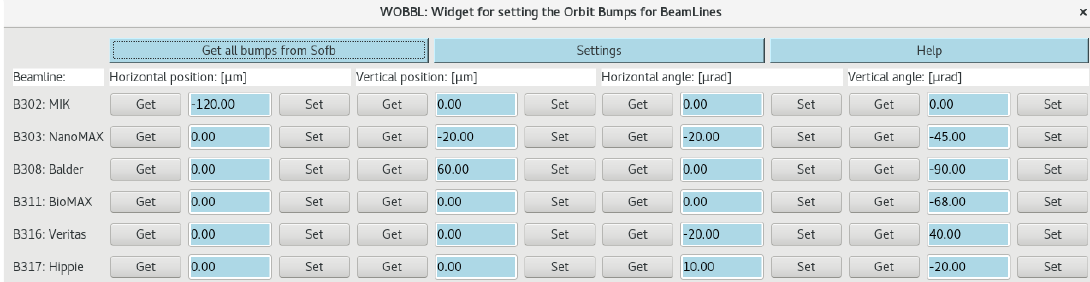
Figure 9. Widget for setting the Orbit Bumps for BeamLines (WOBBL) interface containing the beamlines which are in normal operation for the 3 GeV ring and also the Multipole Injection Kicker (MIK). The widget has input fields for setting each of the four types of bump changes, for each